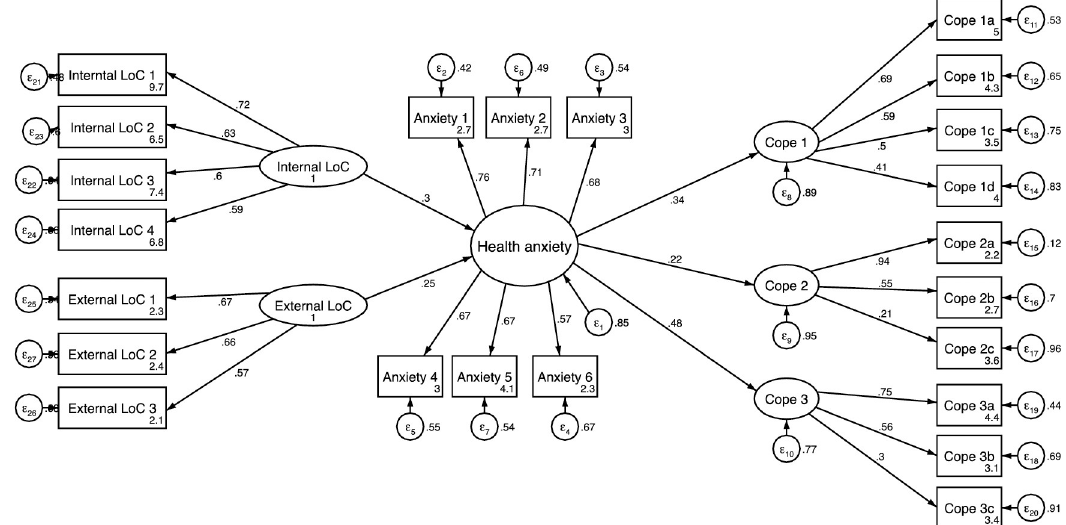
Fig 1. Hybrid model with structural and measurement